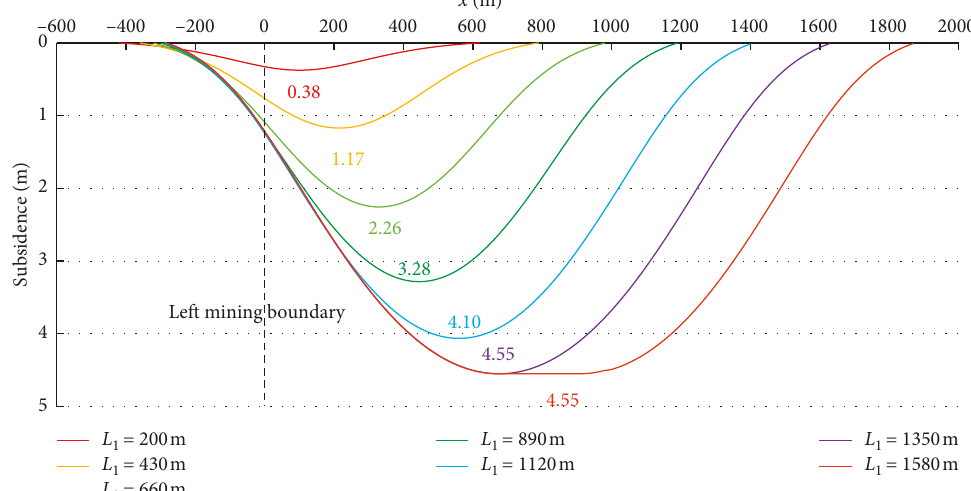
Figure 6: Subsidence curves of main section I when taking different mining dimensions L